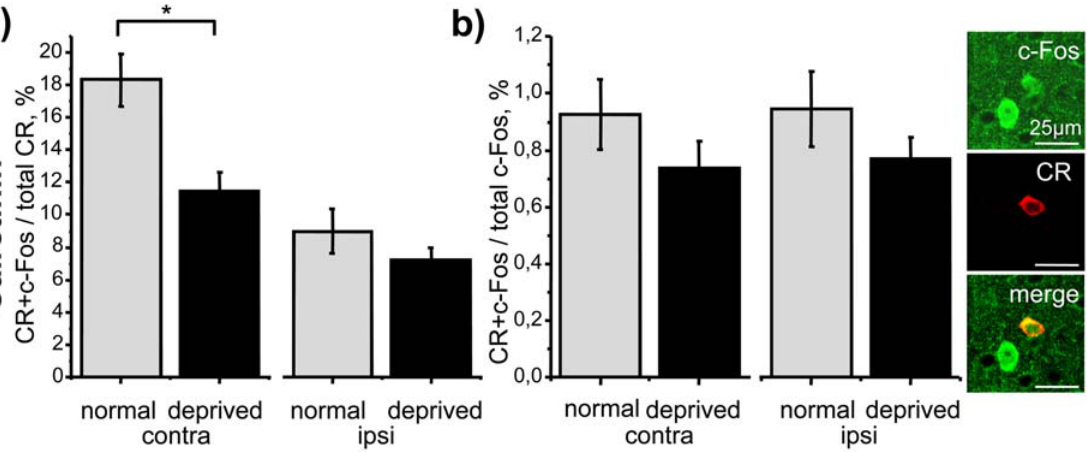
Figure 6. Effect of long-term MD on calretinin interneurons. CR interneurons show an analogous behaviour to the whole GABAergic population with a) a reduction in the D/M ratio (contra, t test, P=0.003; N=10) and b) lack of difference in the D/F ratio respect to control.